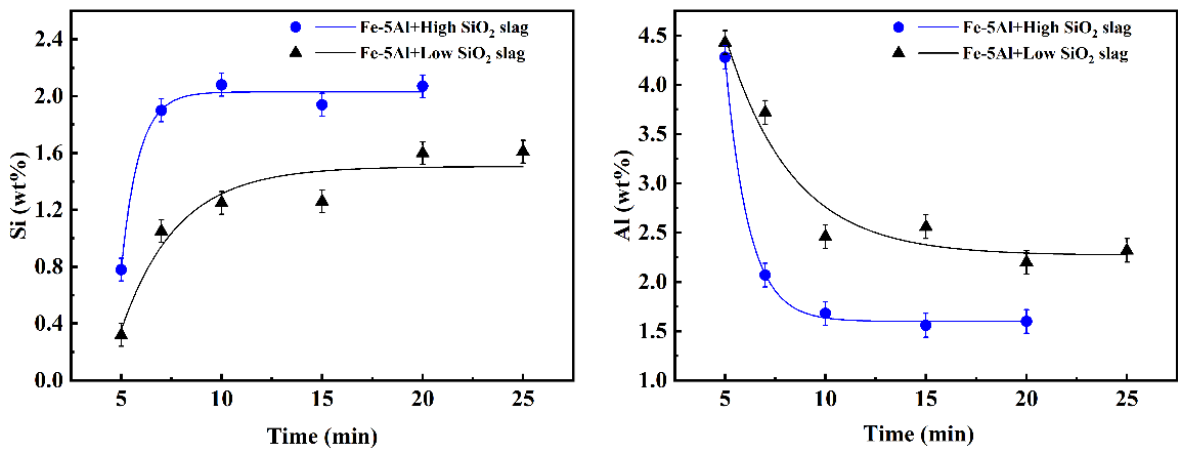
Figure 15. Composition change of molten steel during reaction between Fe-5Al alloy and molten flux.